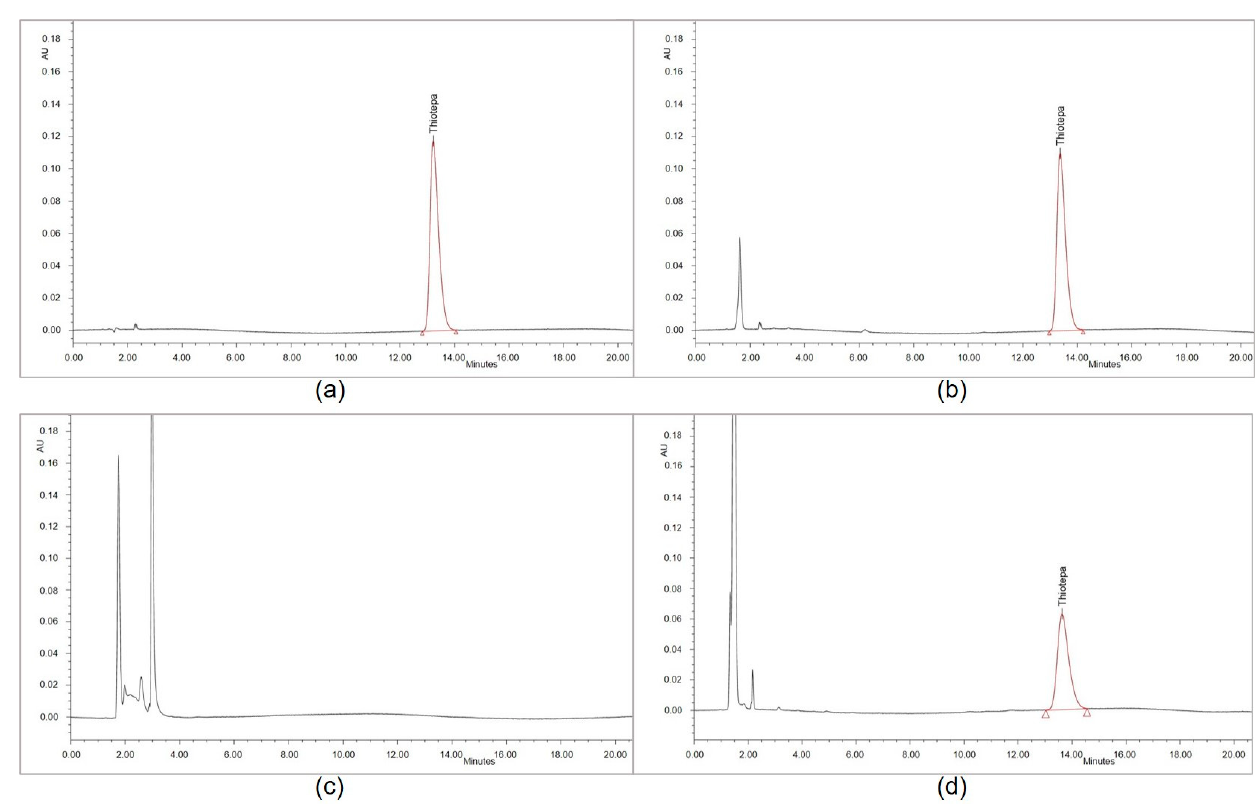
Figure 2. HPLC chromatograms of thiotepa in water without degradation ( a ), heat-degraded ( b ), acidic and heat-degraded ( c ) alkaline and heat-degraded ( d ).